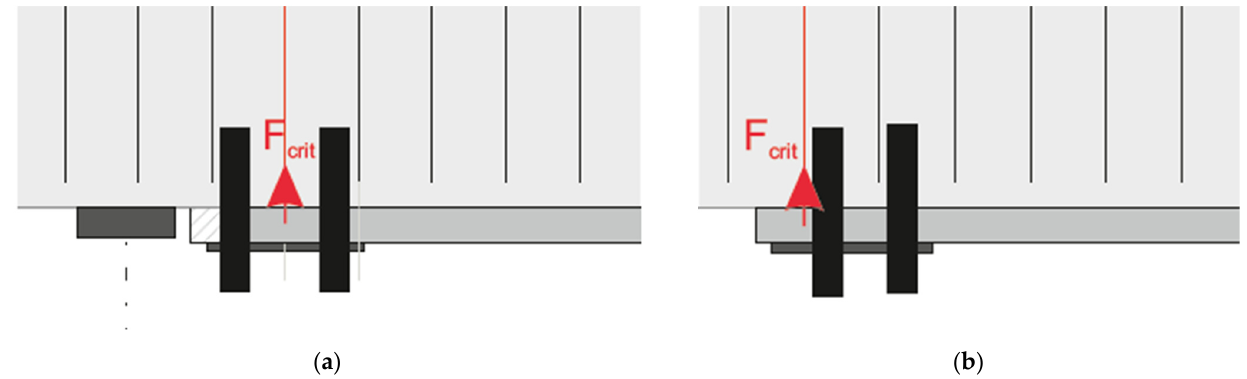
Figure 16. Location of the dowels: ( a ) planned location; ( b ) final location. (Graphic: CARBOCON GMBH).